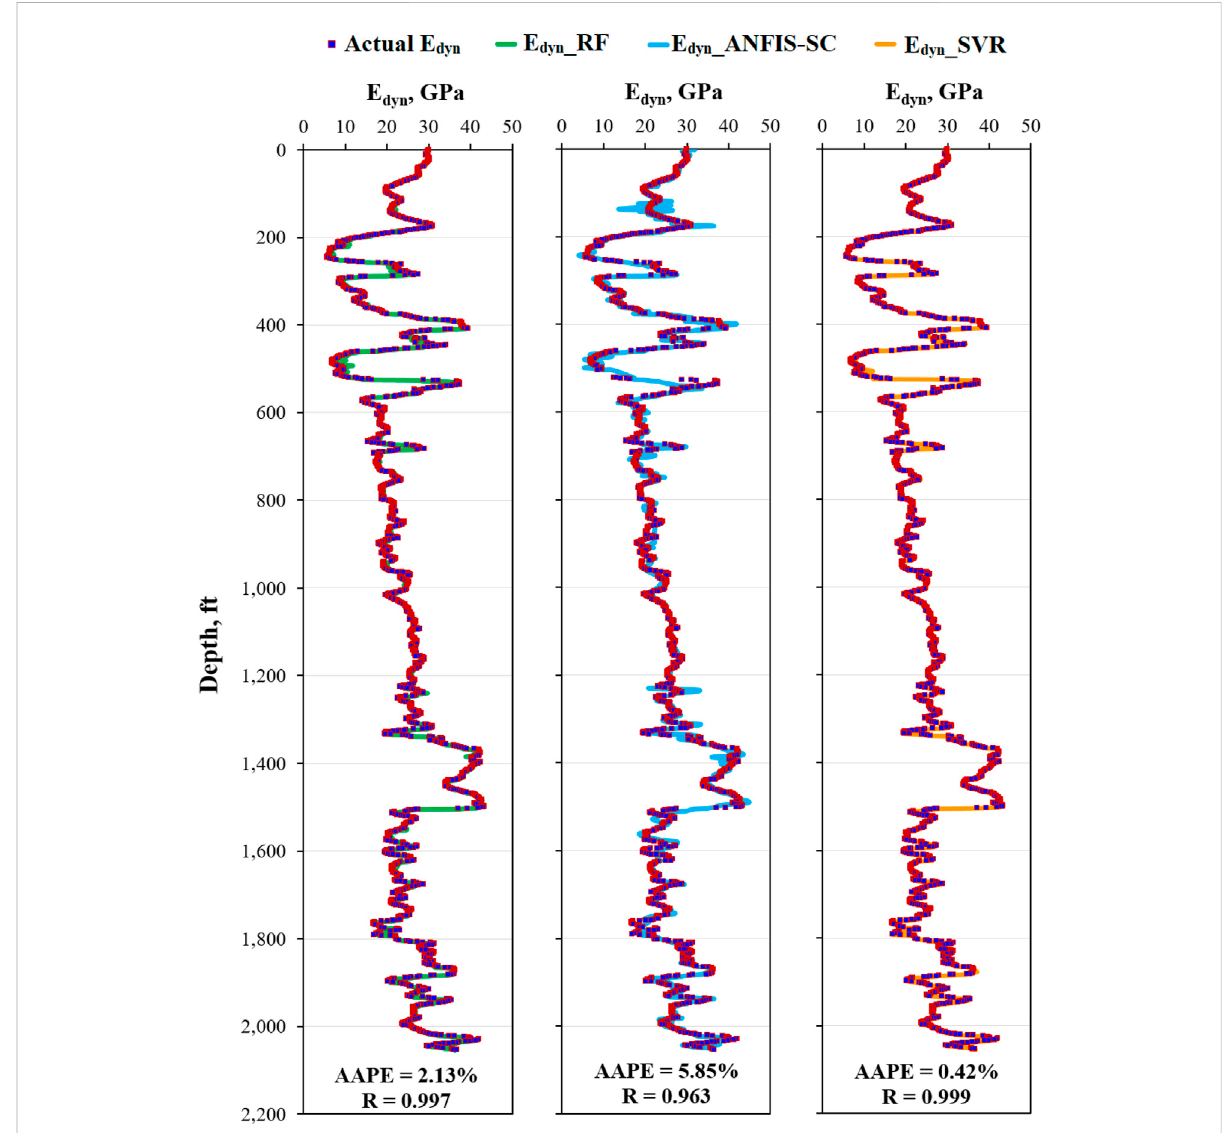
FIGURE 3 Actual and assessed E dyn by the RF, ANFIS-SC, and SVR models for the 2054 training data points of